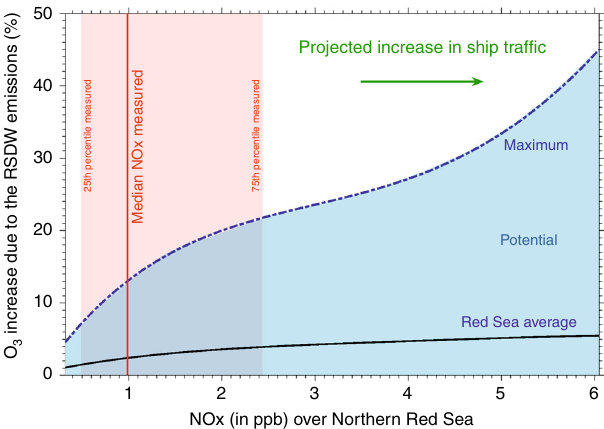
Fig. 5 Projected implications on O 3 formation. Increase in O 3 abundance over the Northern Red Sea due to the Red Sea Deep Water (RSDW) emissions. a Series of ambient NO x mixing ratios was simulated with the EMAC model by modifying the NO x emissions due to shipping. The red line indicates the median NO x mixing ratios over the Northern Red Sea for both legs. Note that over the northern Red Sea the campaign average of NO x ±s.d. mixing ratio was measured to be 2.75 ± 6.29